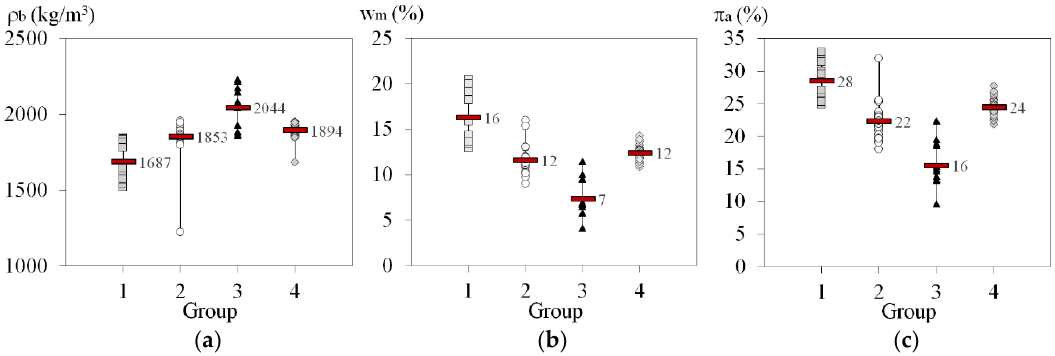
Figure 5. Results grouped by groups: ( a ) dry density; ( b ) absorption, ( c ) open porosity.